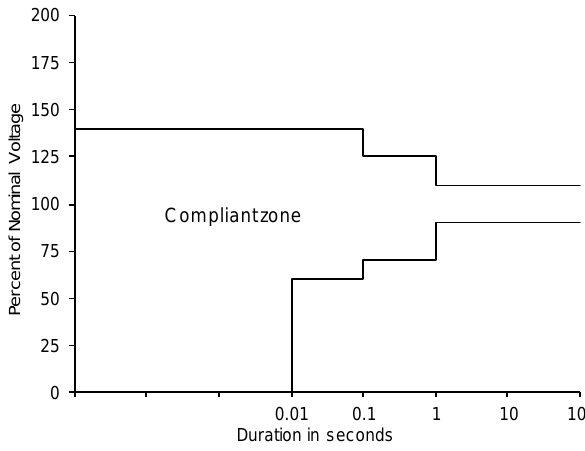
Figure 2. Voltage tolerance of equipment as defined in [17] for railway applications.